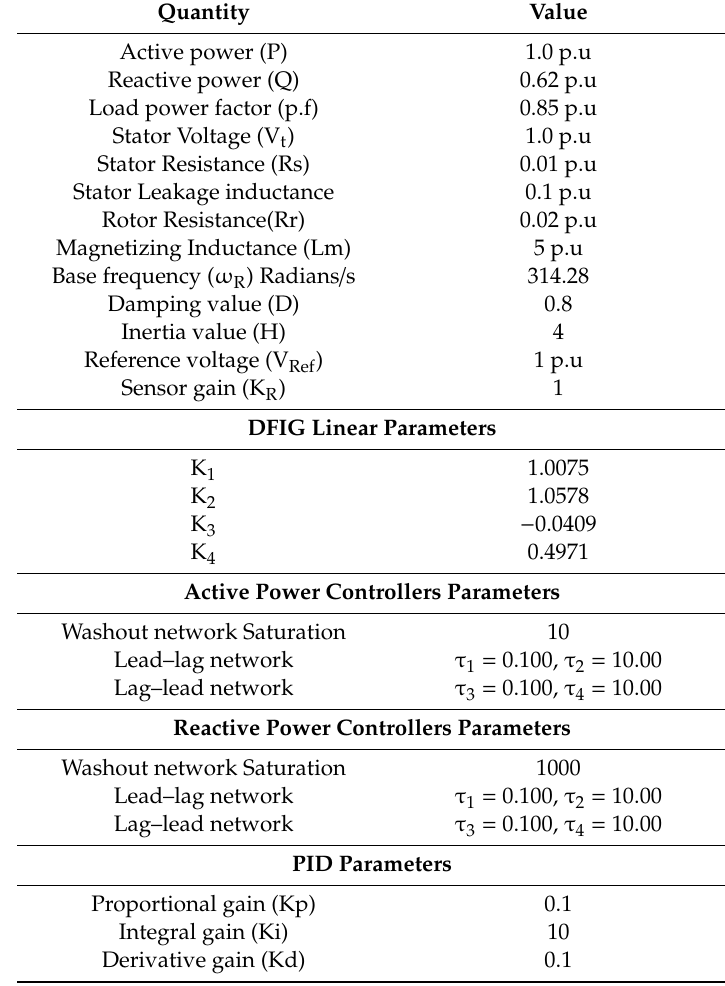
Table 1. Operating parameters for simulation model.